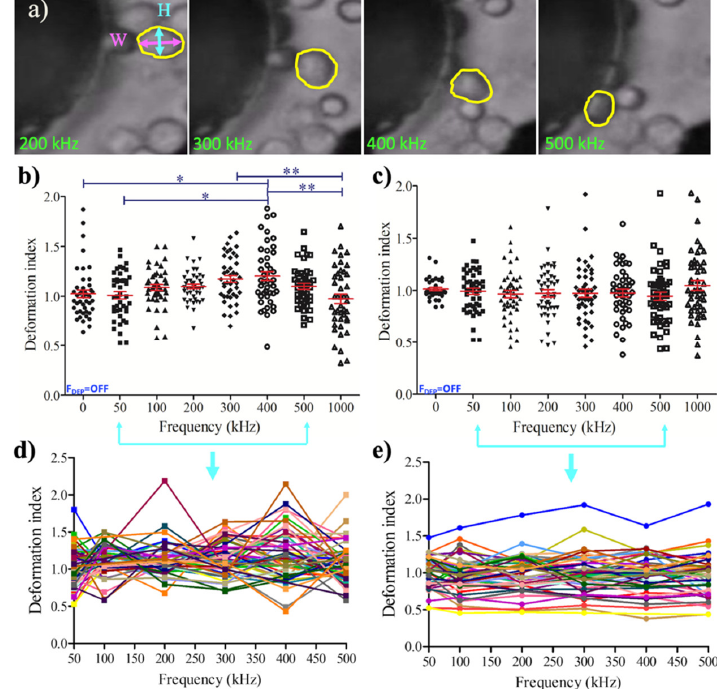
Figure 4. Dielectrophoretic deformation indexes (DDI) of U937 monocytes and U937-di ff erentiated macrophages: ( a ) Representative image for the measurement of DDI. DDI values were presented with mean and standard error for population (n = 45). ( b ) single (n = 47) ( d ) monocyte cells; 45 population ( c ), single (n = 47) ( e ) macrophage cells. Tukey’s multiple comparison test is applied for ( b ). * and ** indicate that data are significantly di ff erent with p < 0.5 and p < 0.05, respectively. Each color displays the change of deformation indexes of single cells during the frequencies applied for the range of 50–500 kHz in ( d ) and ( e